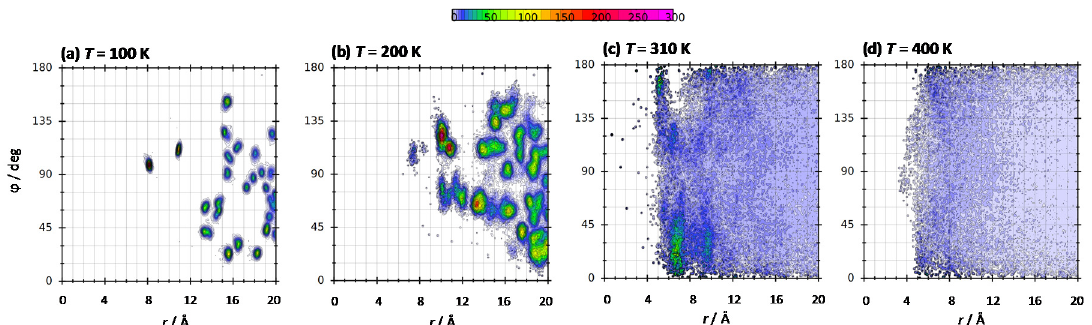
Figure 13. Combined distribution function for the reported distance and angle in ω THAL + (1- ω ) water mixtures ( ω = 0.112) as a function of temperature. Angle, φ , and distance, r , defined as in Figure 12.